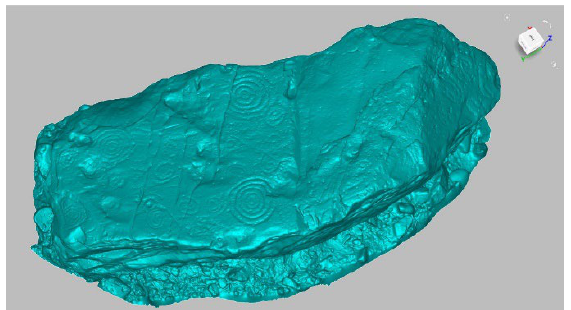
Figure 11a . 3D mesh model generated using SD data (3.7 million